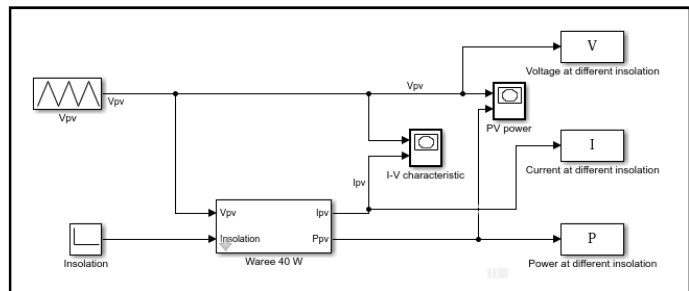
Figure 5. Simulation of Waree solar panel 40 watt.